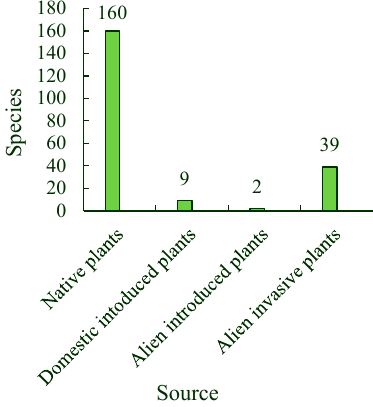
Figure 4. Spontaneous plant species from different sources.